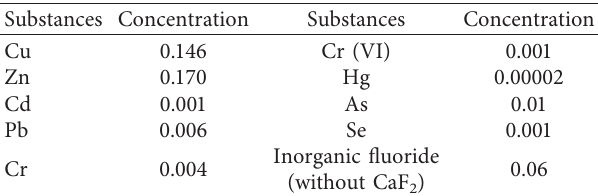
Table 4: Results of the leaching test on coal